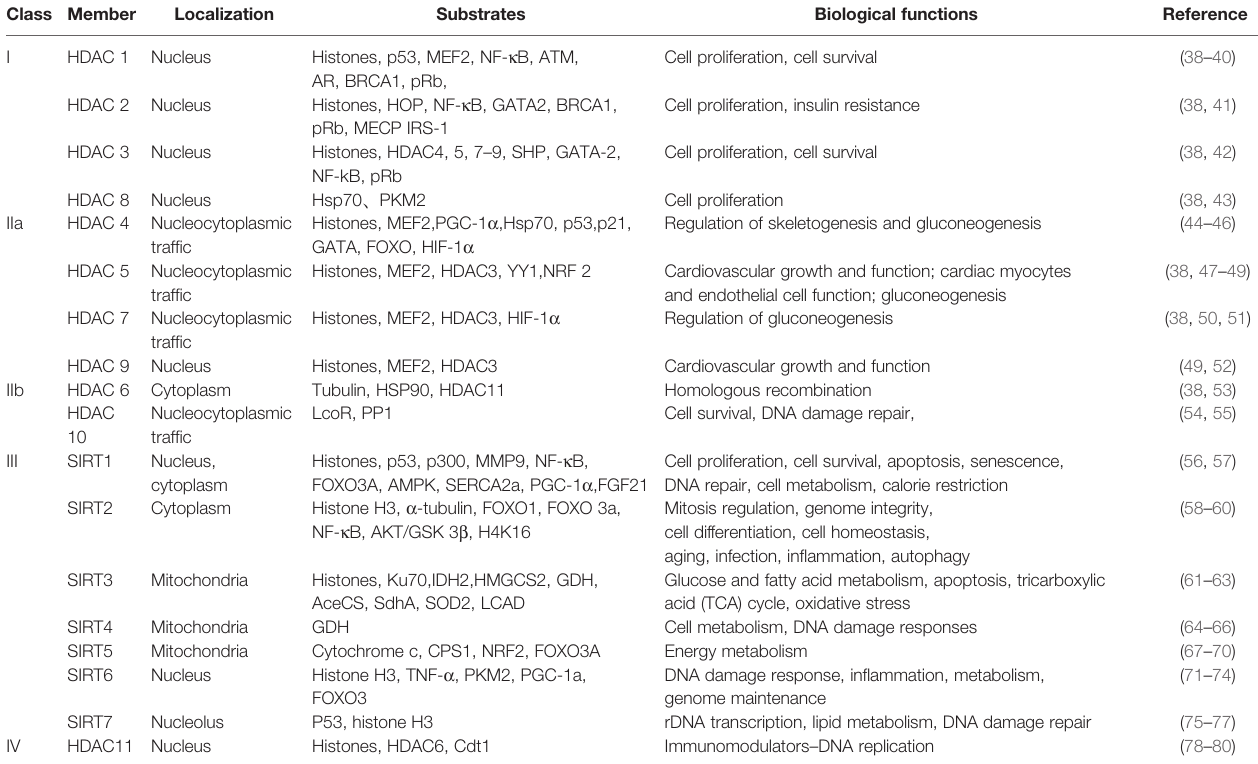
TABLE 1 | The HDAC family: classi fi cation, cellular localization and